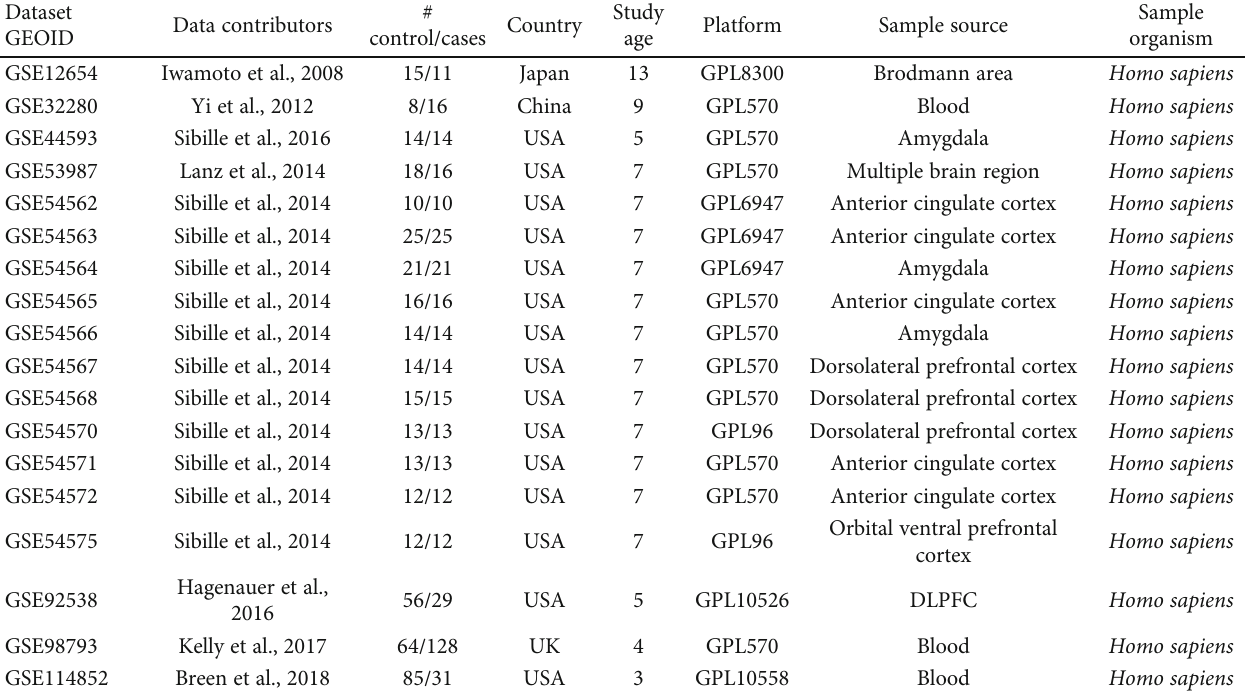
Table 1: The 18 major depression disorder RNA expression datasets from